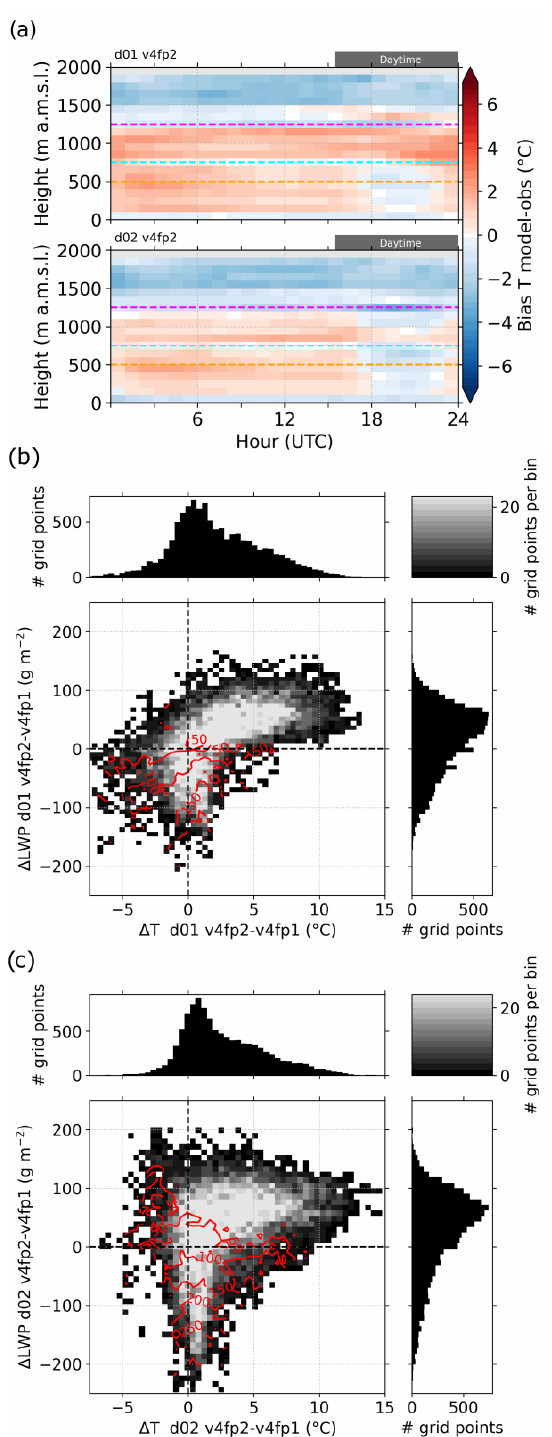
Figure 11. (a) Twenty-four-hour composites of near-surface temperature bias averaged over the CAP period (13–16 January) for v4fp2. Before calculating the composites, the temperature bias and radiation fluxes are computed at the location of the individual surface stations and then averaged over 100m height bins. The horizontal dashed lines indicate different height levels with colors corresponding to terrain contours in Fig. 7. Relationship of the change in liquid water path ( (cid:49) LWP) and near-surface temperature ( (cid:49)T ) between both forecast periods (v4fp2 minus v4fp1) for (b) domain d01 and (c) domain d02. The distributions are computed for surface stations below 500ma.m.s.l. for all nighttime hours during the CAP period. Red contours indicate the distribution of the LWP in